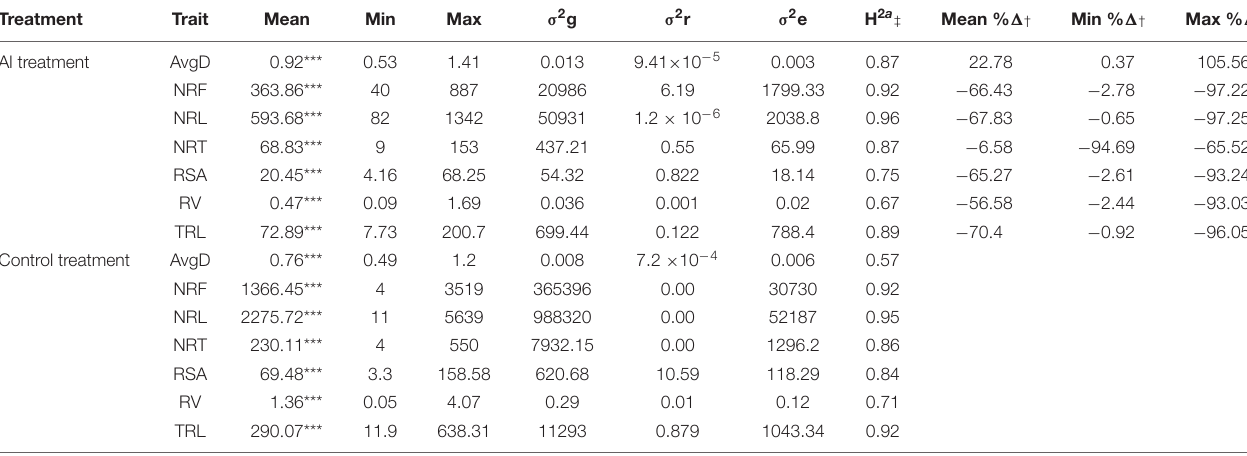
TABLE 1 | Mean, Minimum (Min), Maximum (Max), genotypic variance ( σ 2g), replication variance ( σ 2 r) error variance ( σ 2 e) and heritability values of traits measured for the root phenotypes of 227 common bean genotypes from the Andean Diversity Panel (ADP) grown under Al treated and control hydroponic conditions. Treatment